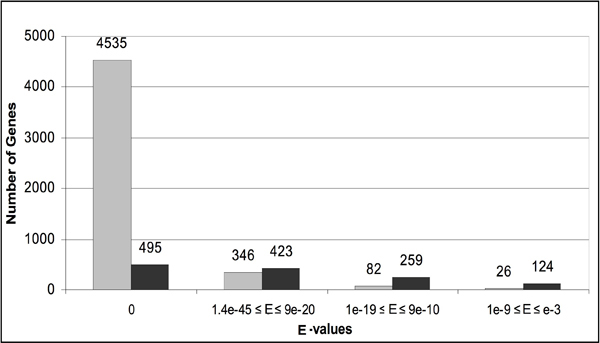
Features of reciprocal best BLASTP matches between GO-annotated proteins and predicted proteins of Magnaporthe oryzae. The vast majority of the matches to characterized proteins have high sequence identity over much of their length. Shaded grey bars indicate matches with a percentage of identity (pid) ≥ 40%, and shaded black bars indicate pid < 40%.